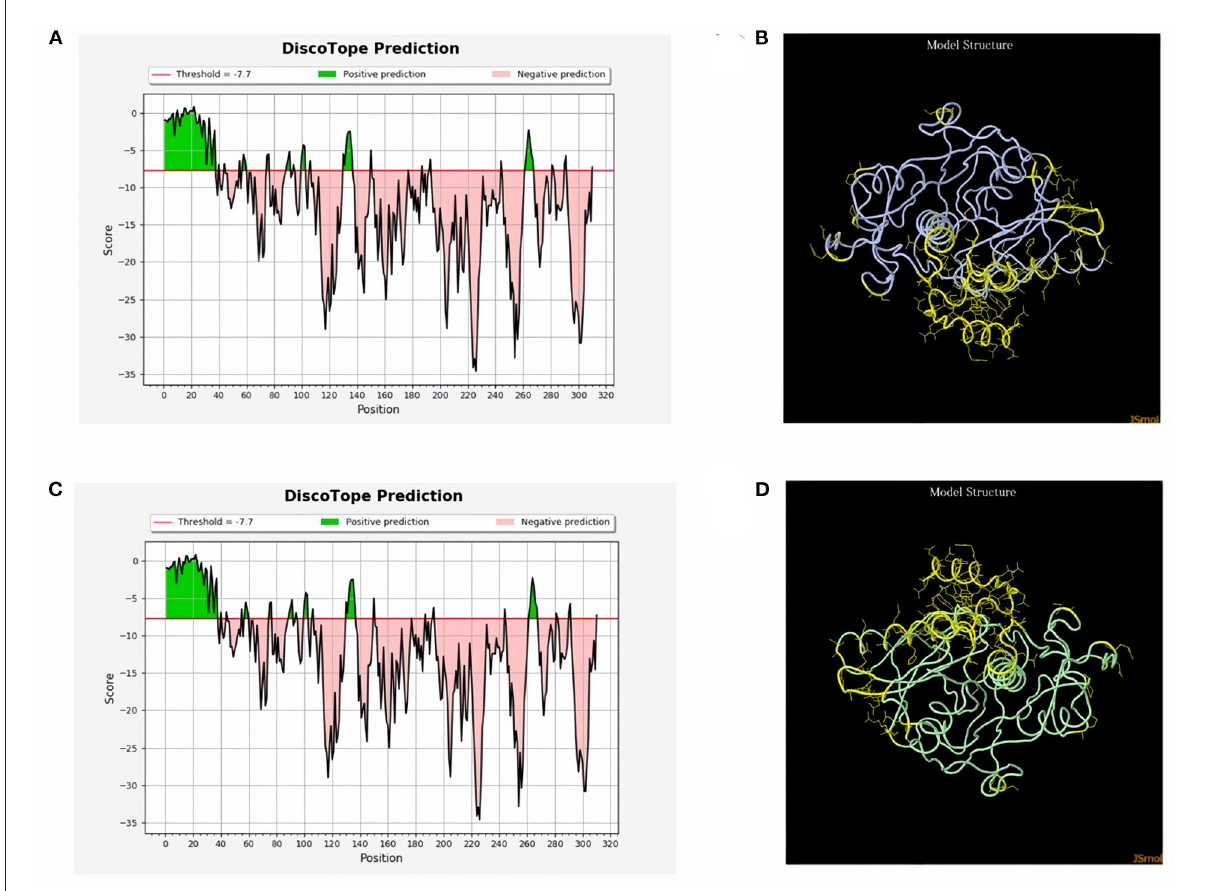
FIGURE10 Disco Tope: Discontinuous (conformational) antibody epitope 3D structures prediction of FhCatL1. Crystal Structure of ProCathepsin L1 from Fasciola hepatica (206X). Chain A PDB file was used as input data for Disco Tope searches (https://www.rcsb.org/structure/2O6X) for visualization of 2 D chart (A) and Jmol visualization (B) of the predicted epitope. Chain B PDB file was used also as input data for visualization of 2 D chart (C) and Jmol visualization (D) of the predicted epitope shows the epitope residues are in yellow and the rest of the protein is in violet